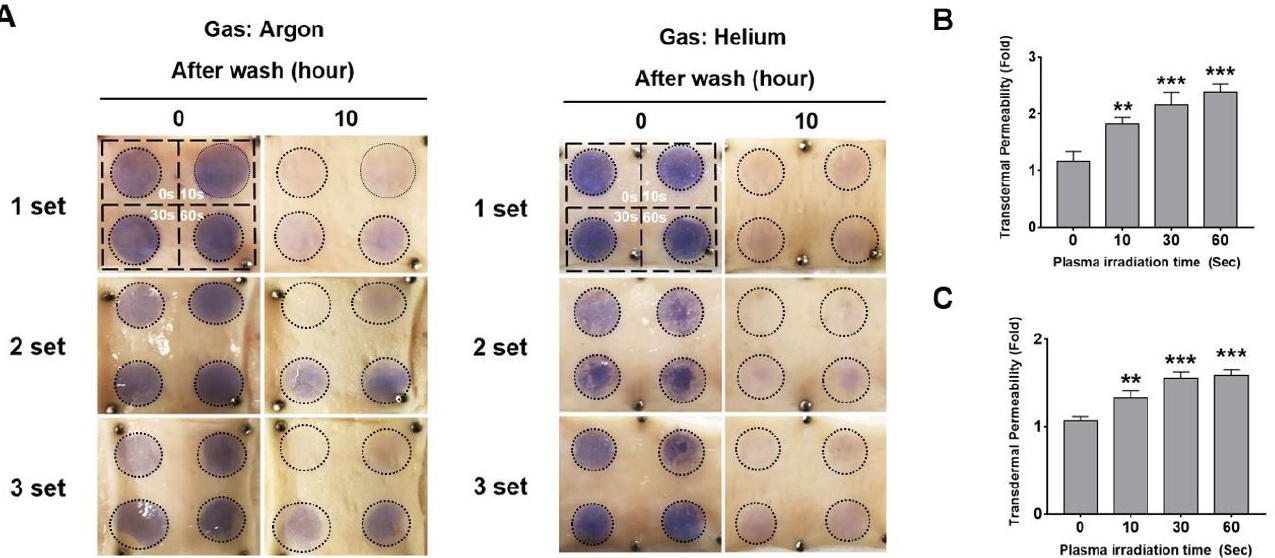
Figure 3. Optical emission spectroscopy of argon and helium plasma jets with a wavelength range from 200–900 nm.